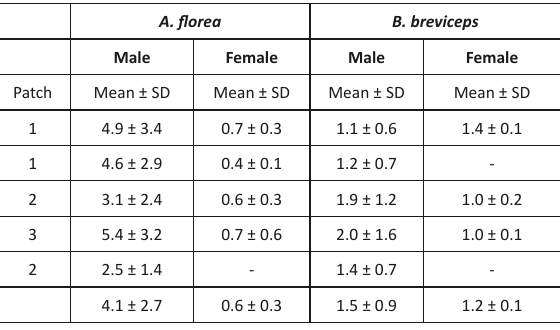
Table 2. Time (in seconds) spent on male and female flowers of B. satrapis by A. florea and B.